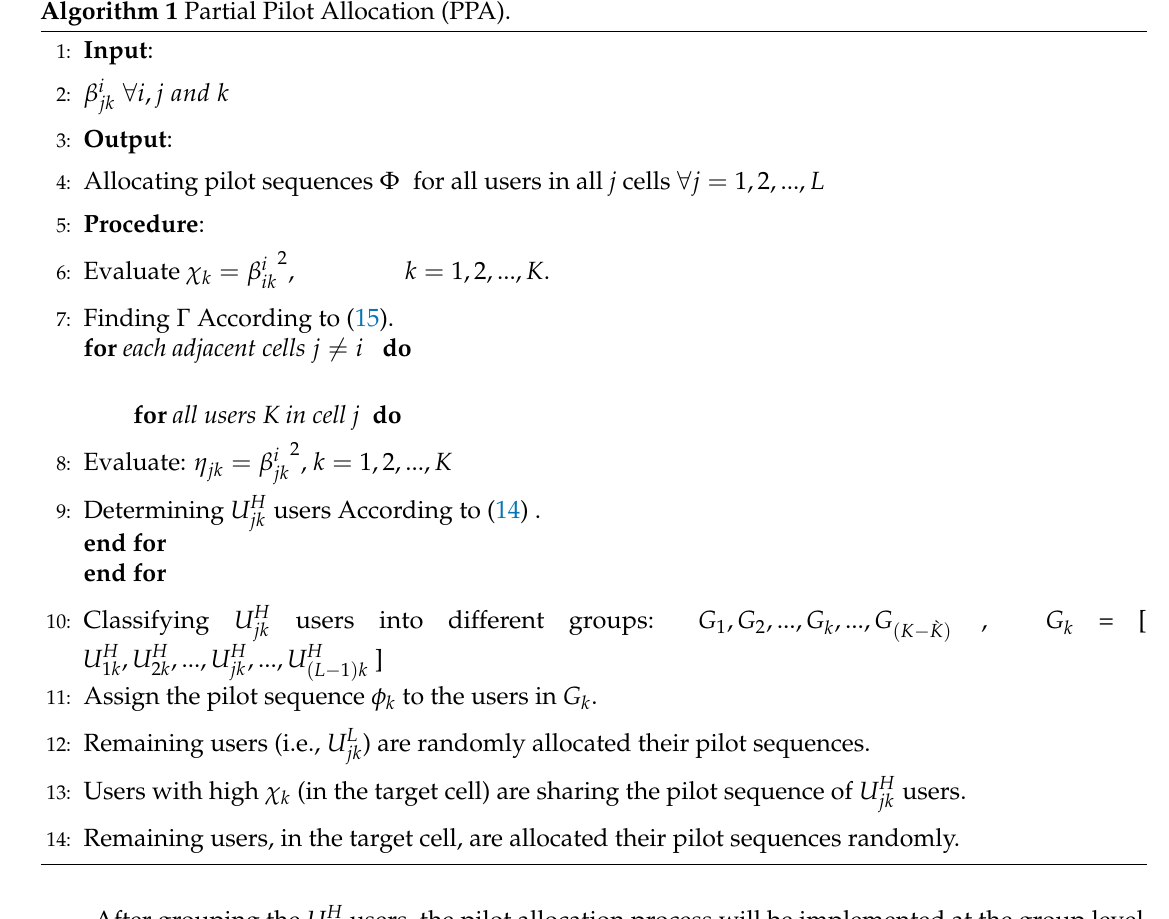
Algorithm 1 Partial Pilot Allocation